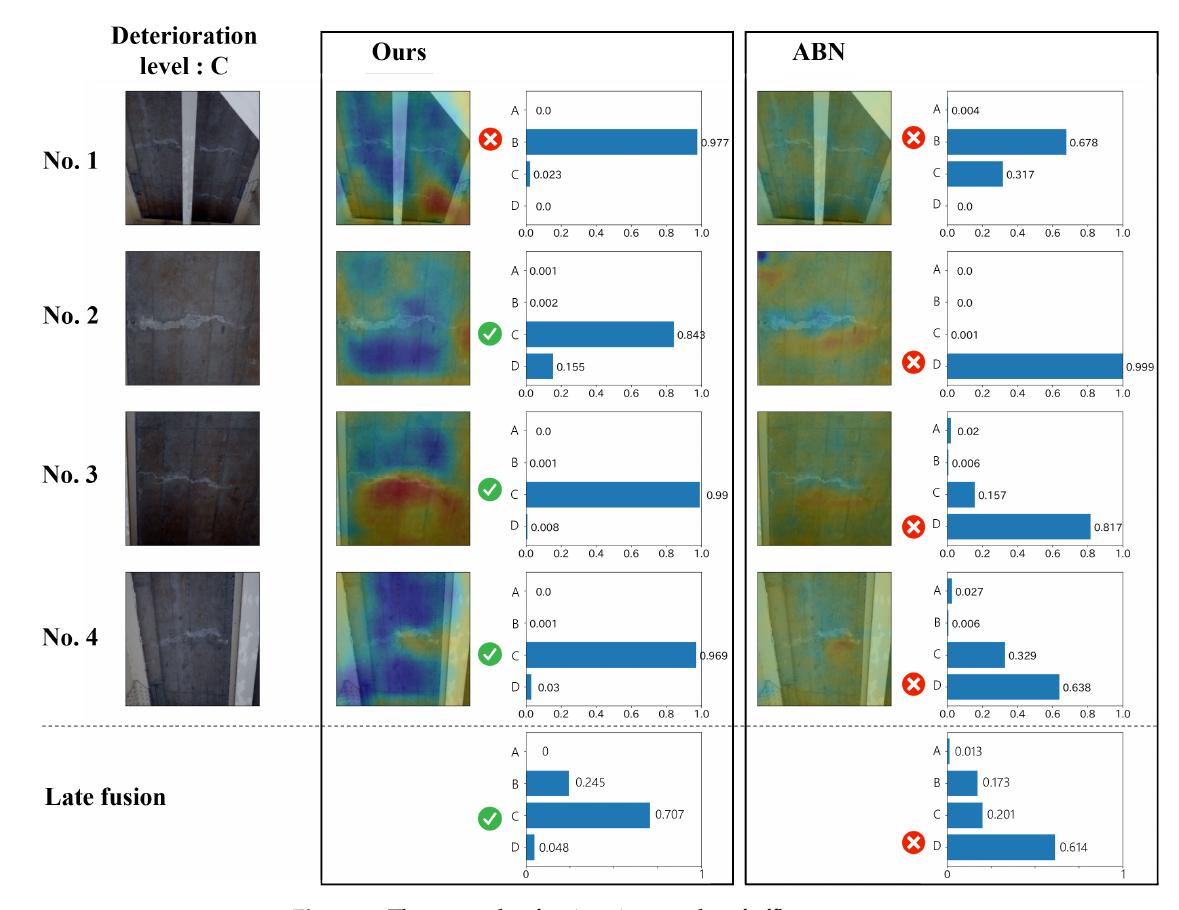
Figure 8. The example of estimation results of efflorescence.